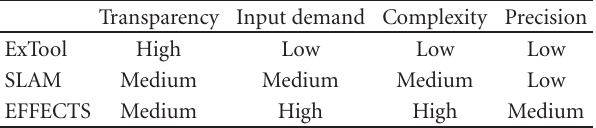
Table 7: Model choice